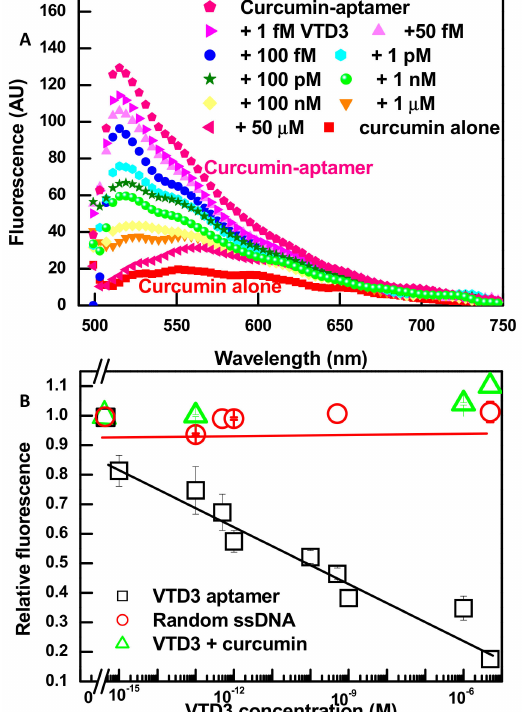
Figure 2. ( A ) Fluorescent spectra showing the fluorescent enhancement upon the aptamer-curcumin complex formation (concentrations of VTD3 aptamer and curcumin are 100 nM and 0.6 µ M, respectively) and characterizing the response towards increasing concentrations of VTD3. ( B ) Di ff erential change in fluorescence (relative fluorescence) versus the concentration of VTD3. The response towards VTD3 is also shown for control experiments lacking the VTD3 aptamer (by replacing the aptamer with a random ssDNA or measuring the fluorescence of curcumin exposed to increasing concentration of VTD3). Error bars represent standard deviations from two